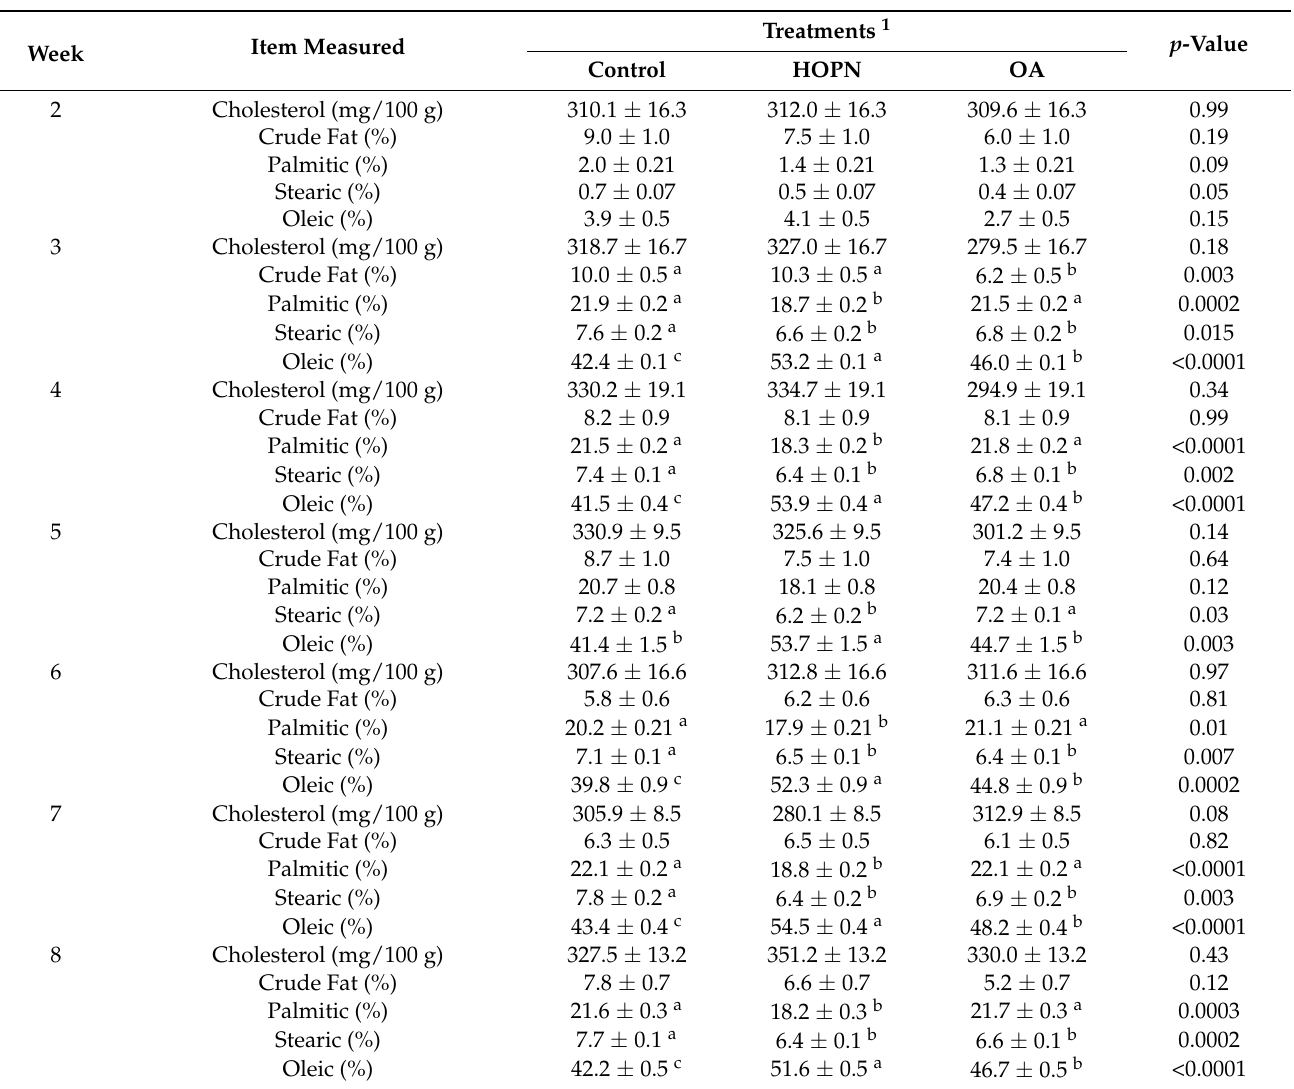
Table 5. The effect of feeding laying hens a high-oleic peanut (HOPN) diet or an oleic fatty acid (OA) diet on the fatty acid profile of the eggs produced.